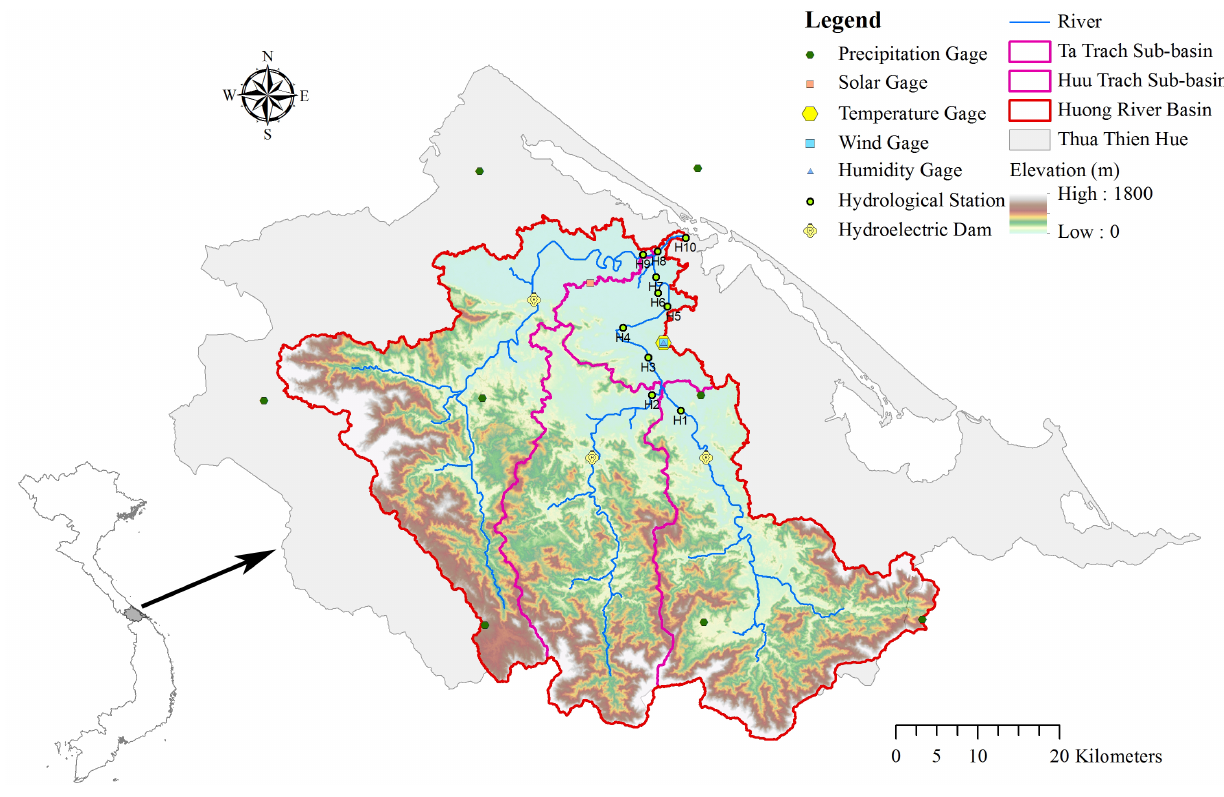
Figure 1. The Huong River basin, central